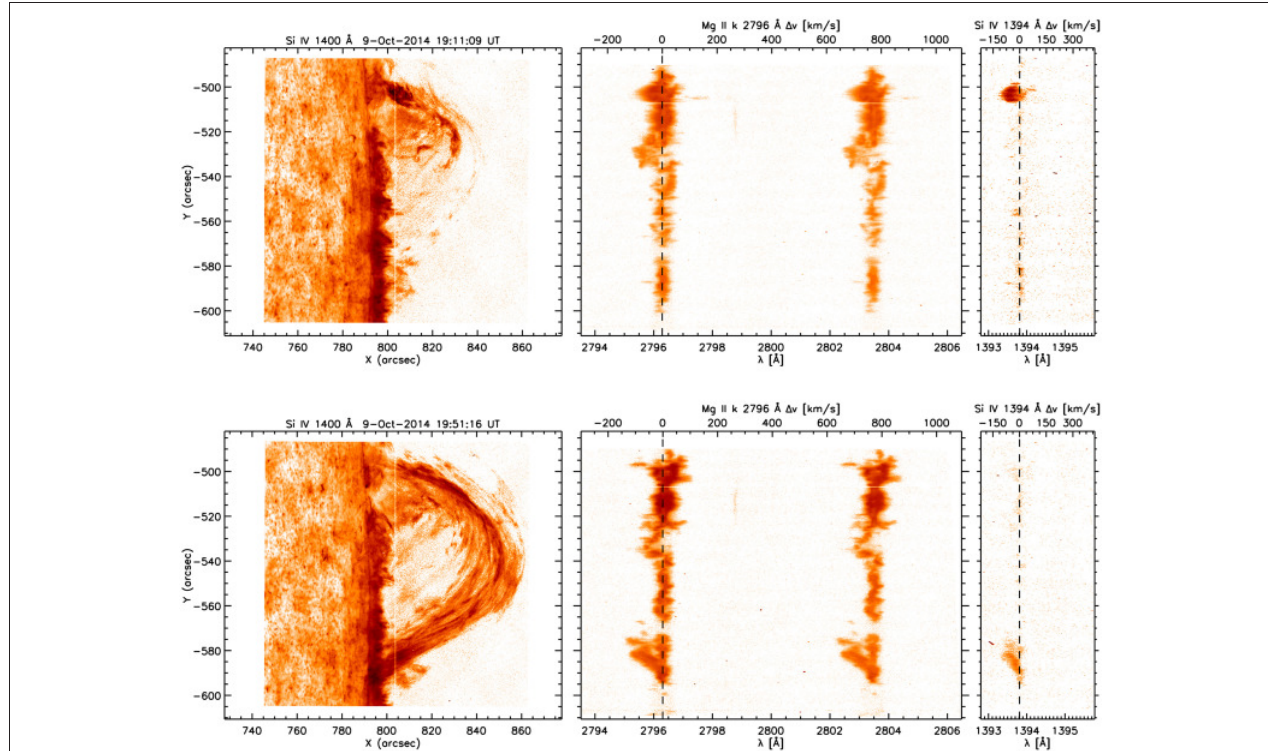
FIGURE 6 | Left: IRIS Si IV 1400 Å. Middle : Mg II 2796 Å spectra. Right : Si IV 1394 Å spectra. In each spectra panel, the top axis x -axis is the Doppler velocity whose reference wavelength is marked by a dashed line.